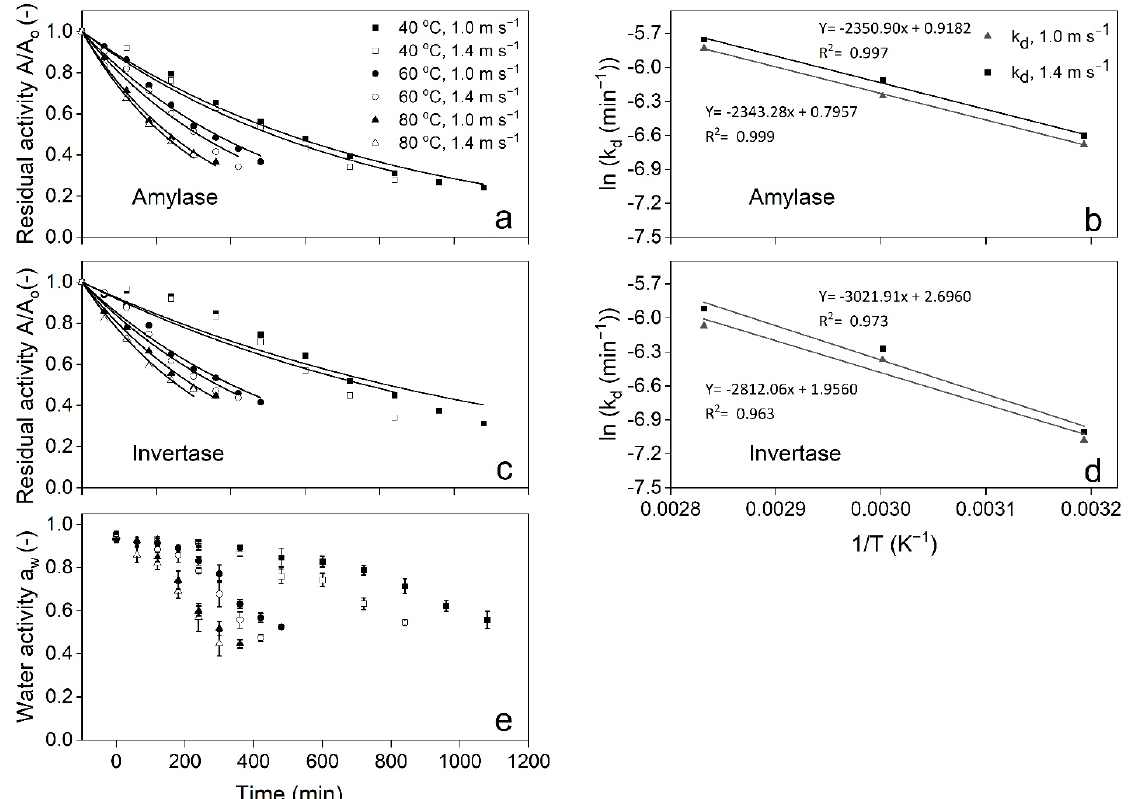
Figure 3. Residual activity A/A o and Arrhenius plot for the energy of deactivation of ( a , b ) amylase and ( c , d ) invertase; and ( e ) water activity during drying of mango variety Sindri at 40 °C, 60 °C, and 80 °C; air velocity 1.0 m s − 1 or 1.4 m s − 1 .